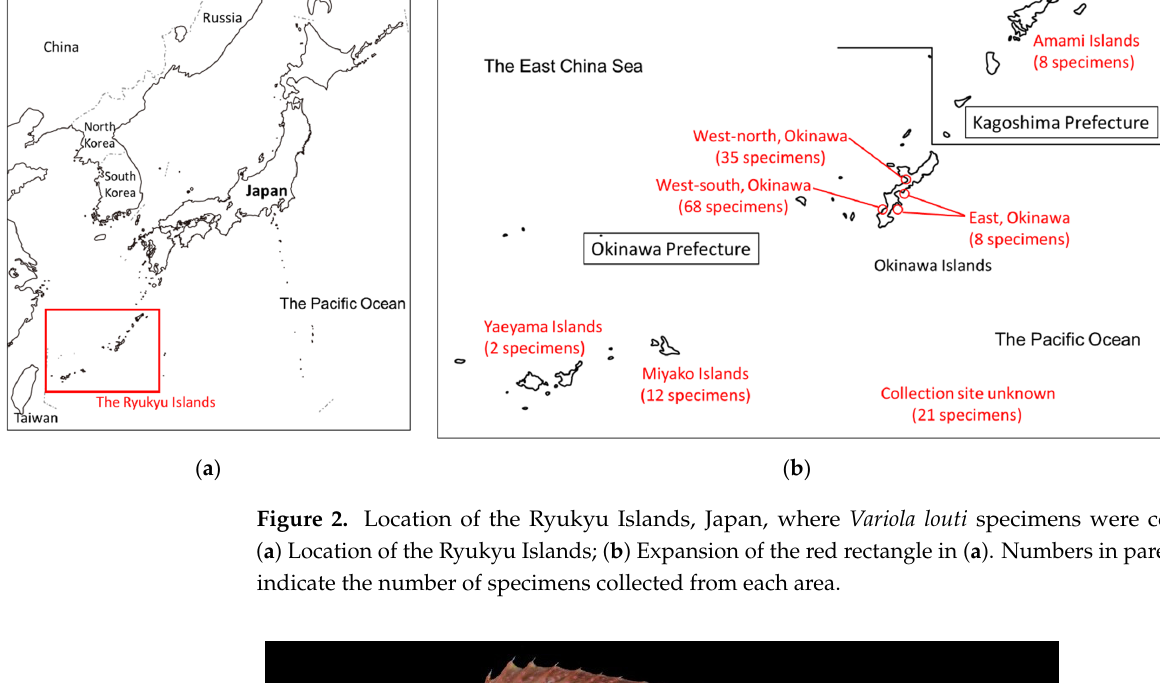
Figure 1. Structures of the representative ciguatoxins (CTXs) reported from the Pacific. ( a ) CTX1B group toxins; ( b ) CTX3C toxins.